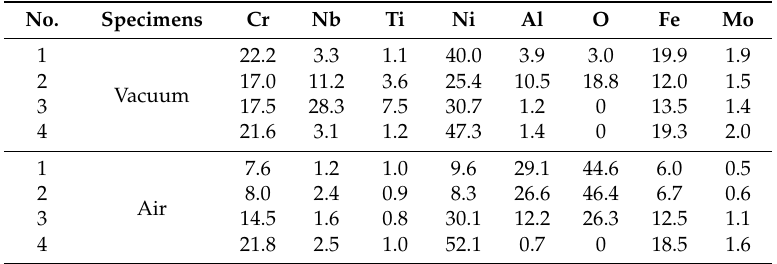
Figure 6. BSE images of the SPS-consolidated IN718 bulk alloys, in which ( a ) represents the result obtained from the consolidation of non-oxidized powders, ( b , c ) are from the pre-oxidized powders at 800 °C for 5 min in vacuum and in air, respectively. Table 3. Results of EPMA WDS point analysis obtained from the residues marked in Figure 7a, and b, respectively (in atom